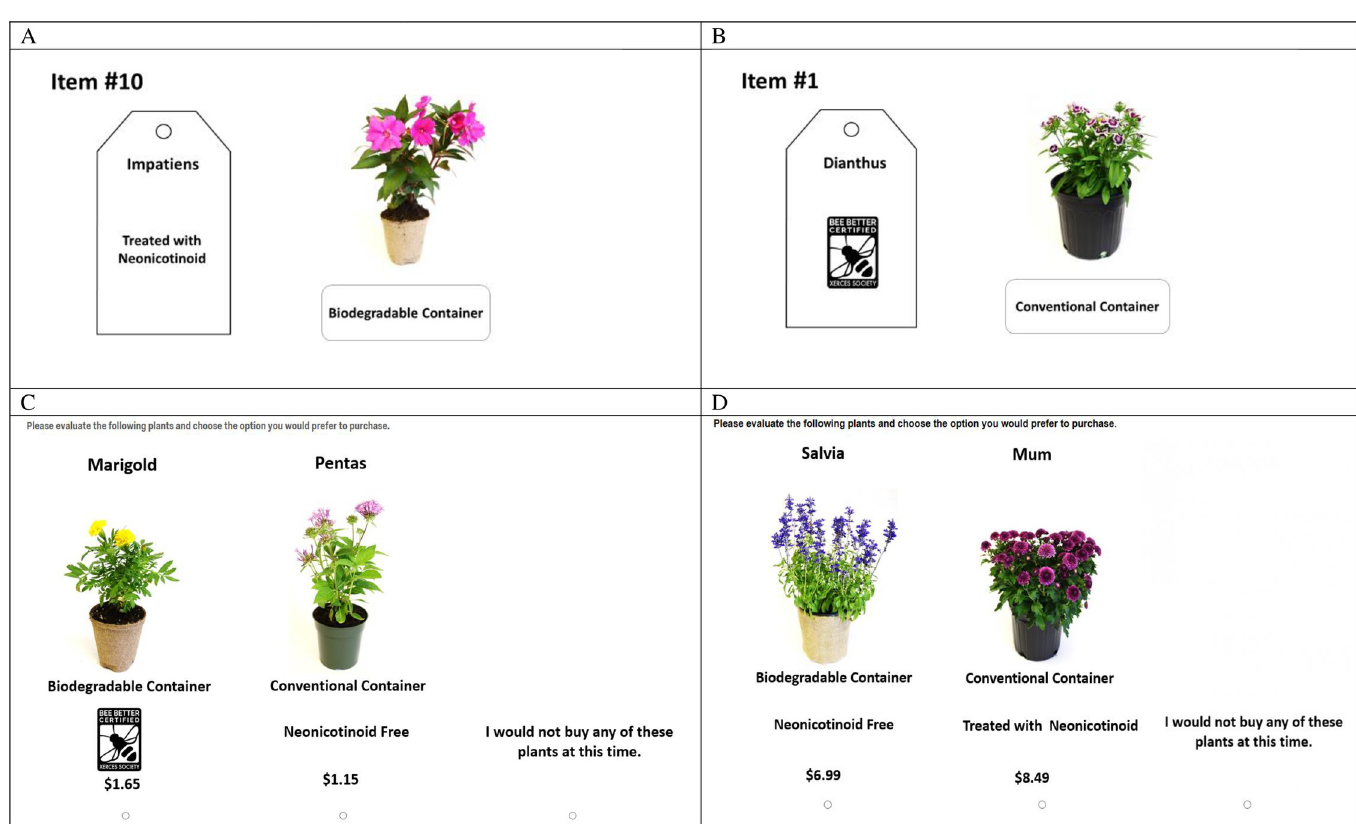
Fig 1. Representive examples of the experimental products. (A) Example of annual bedding plant auction item, (B) example of perennial plant auction item, (C) example of annual bedding plants choice set, (D) example of perennial plants choice.